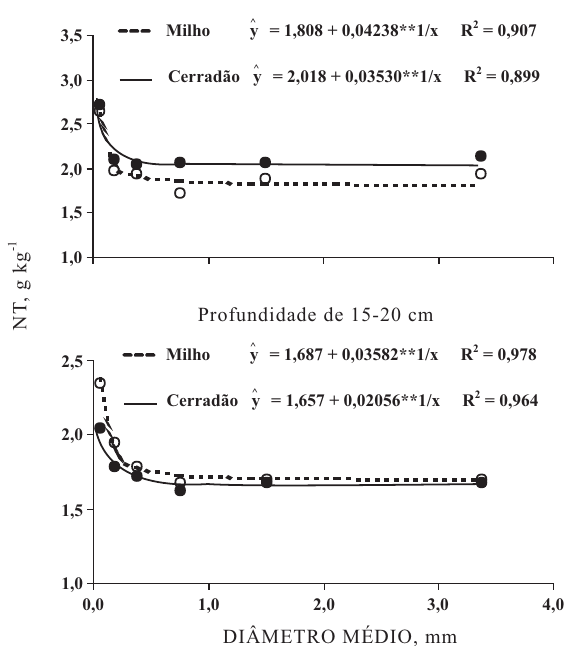
Figura 2. Nitrogênio total (NT), em relação ao diâ- metro médio dos agregados, nas profundidades de 5–10 e 15–20 cm de um Latossolo Vermelho sob vegetação natural de Cerradão e sob cultivo com milho por 30 anos.**: significativo a 1 % pelo teste